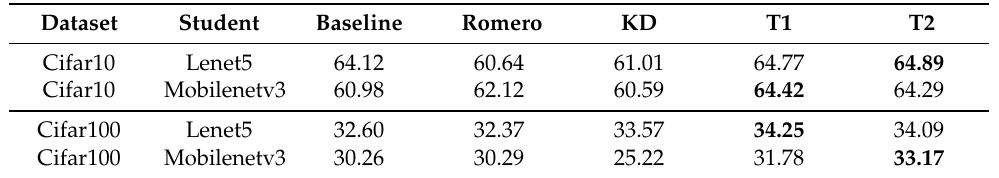
Table 3. Accuracy in percentage after 200 epochs over Cifar10 and Cifar100 using InceptionV3 (T1) and T1 plus Resnet50 (T2) as teachers. The baseline here is the model that does not have the modified layer because we make use of the